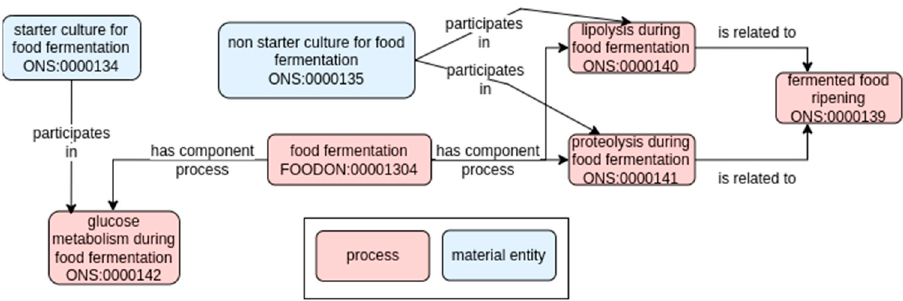
Figure 1. Top-level model for the metabolic pathways involved in dairy fermentation. Solid arrows represent semantic relations in RO (annotated with their label), and pink and blue rectangles refer to process or material entity, respectively. The label and the term ID (formatted as an ontology prefix followed by a number) are reported for each class.